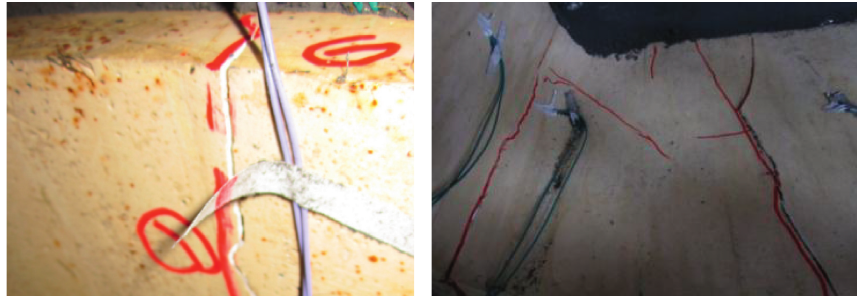
Figure 10: Lining cracks of basalt fiber-reinforced concrete.